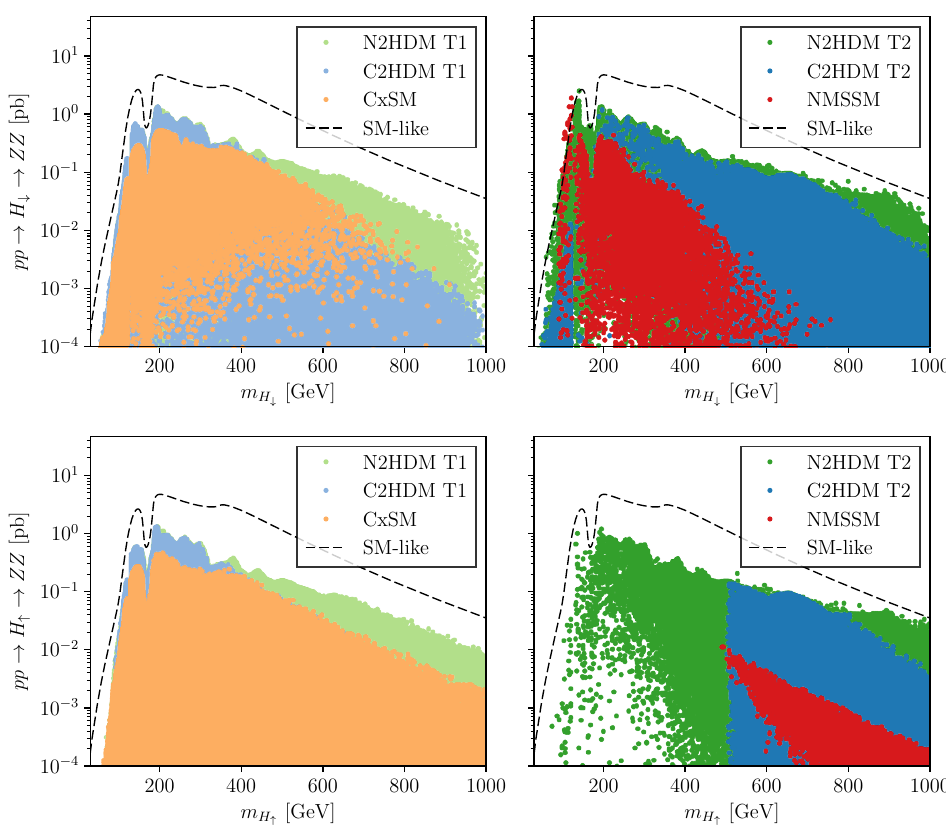
Figure 8 . Signal rates for the production of H # (upper) and H " (lower) decaying into a pair of Z bosons at the p s = 13 TeV LHC as a function of its mass. Left: the CxSM (orange), the type I N2HDM (fair green) and C2HDM (fair blue). Right: the NMSSM (red) and the type II N2HDM (dark green) and C2HDM (dark blue). The dashed black line denotes the signal rate of a SM Higgs boson of the same